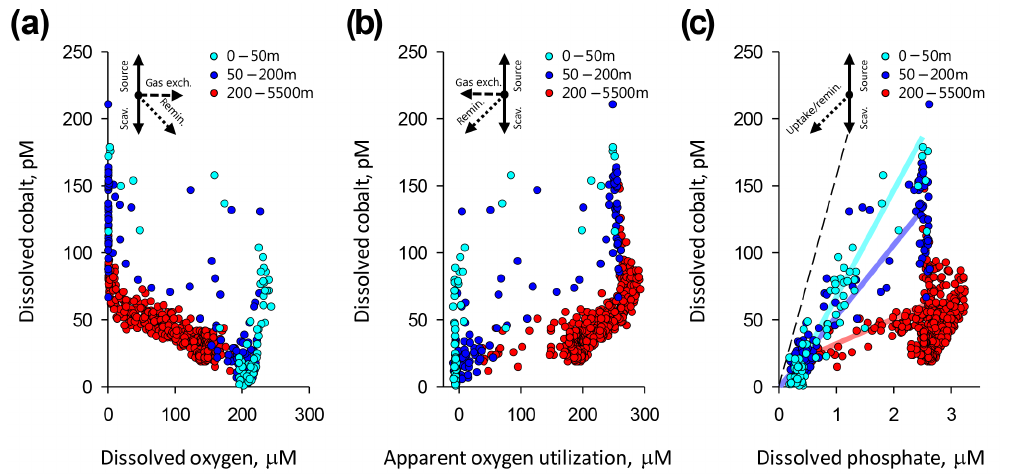
Figure 5. Coupling between dissolved cobalt with O 2 (a) , AOU (b) , and PO 4 (c) . Below 200m (red circles), dCo shows a decreasing linear trend with dissolved oxygen that is obscured upon conversion of O 2 to apparent oxygen utilization, AOU, and a weak relationship with PO 4 . In the surface ocean (0–50m, cyan circles), dCo and PO 4 are strongly coupled but dCo shows no relationship with O 2 or AOU. Samples from 50–200m are plotted in blue. Trend lines in (c) show least-squares regressions of dCo and PO 4 (0–50m, cyan; 50–200m, blue; 200–1000m, red). Also plotted is the median particulate Co : P ratio for 0–50m (146µMM − 1 , dashed line). Major processes affecting these plots are described in vector